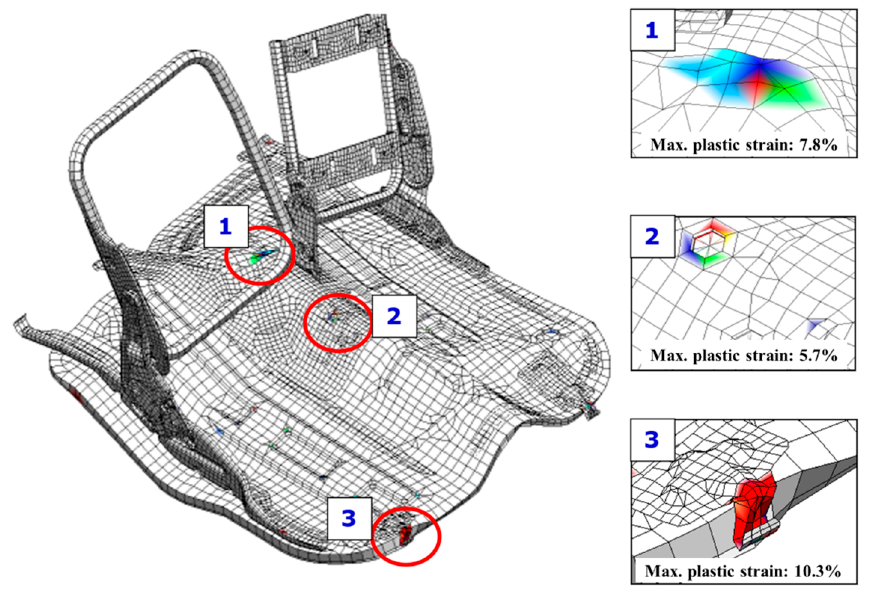
Figure 5. Plastic strain contour results.